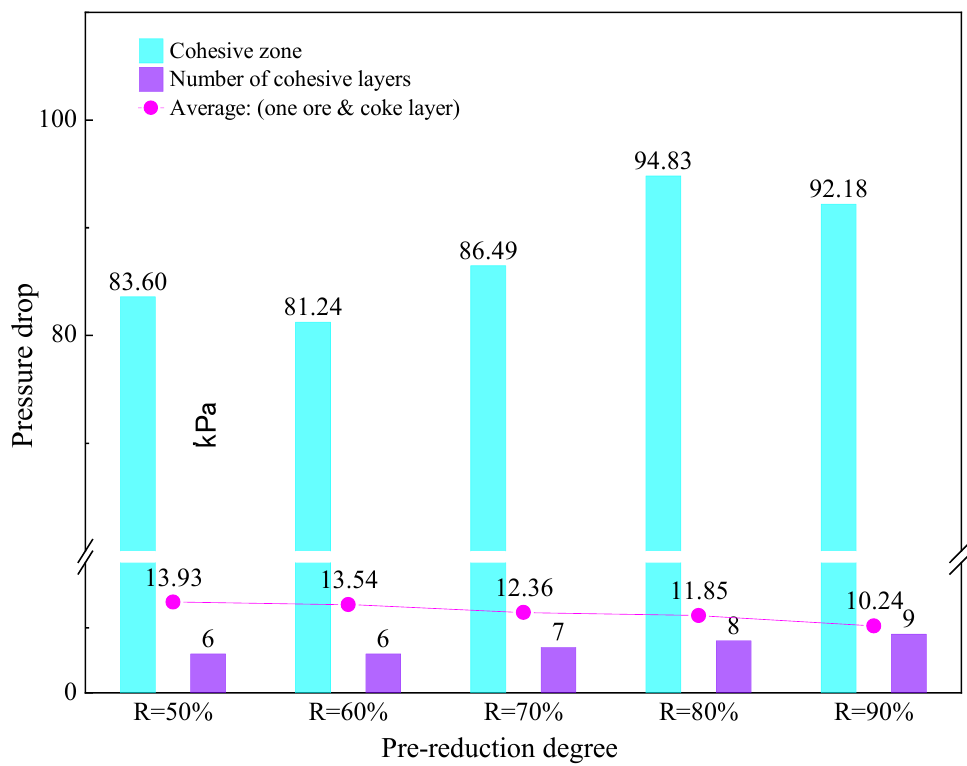
Figure 10. Pressure drop of the cohesive zone and the average pressure drop of one layer.